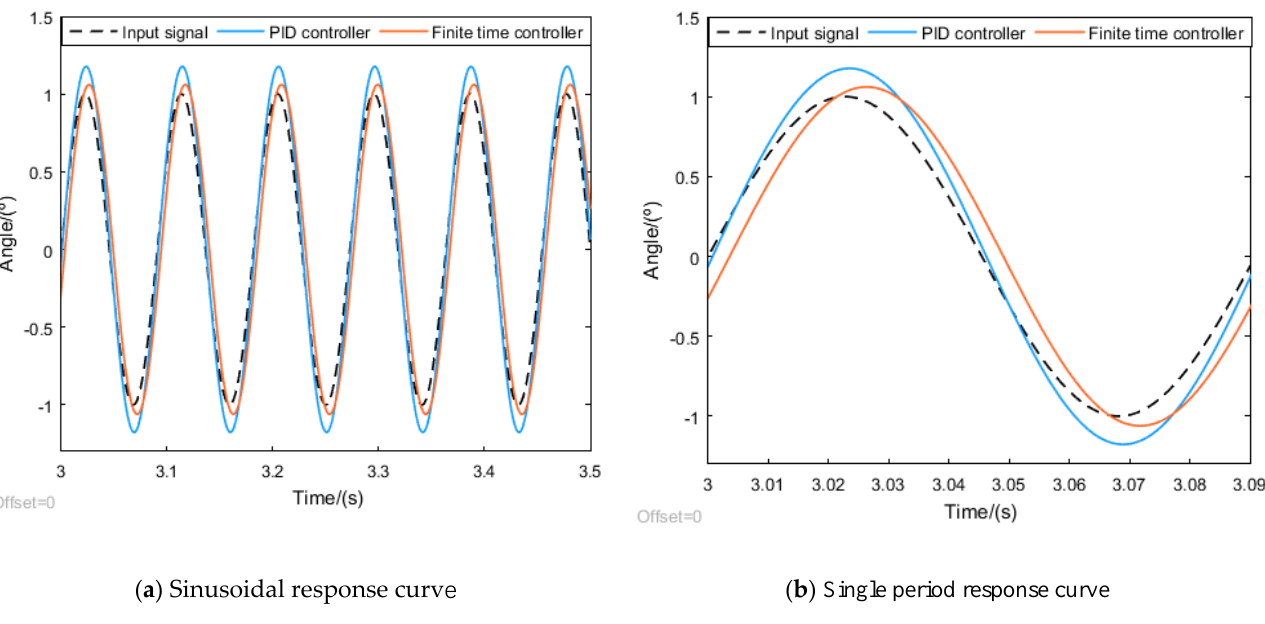
Figure 10. Finite-time composite control response curve of the motor system with 11 Hz and 1° sinusoidal signal.